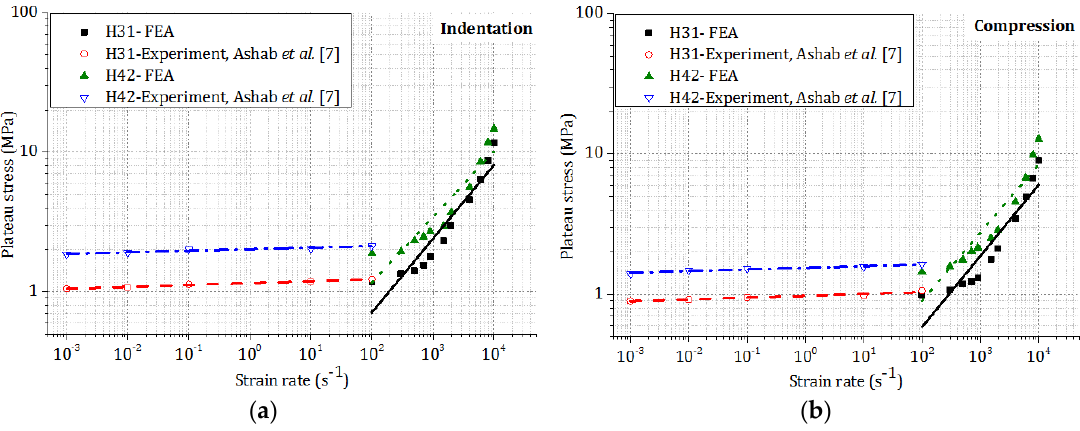
Figure 8. Effect of strain rate on the plateau stresses of two types of honeycombs subjected to: ( a ) indentation; ( b ) compression.